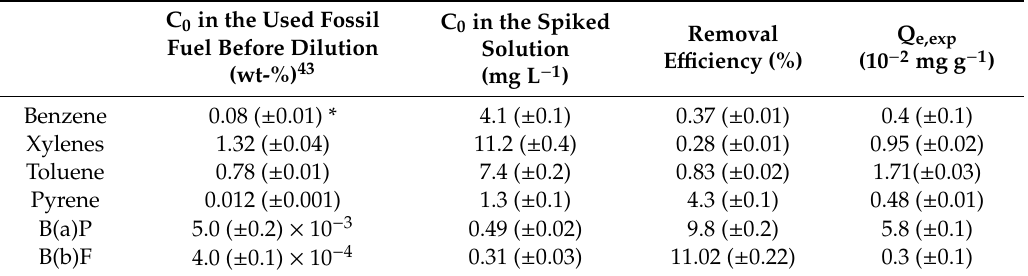
Table 5. Adsorption parameters of aromatic hydrocarbons in a fossil fuel sample by PVA / CS / MA- β -CD hydrogel with intermediate swelling degree. C 0 in the Used